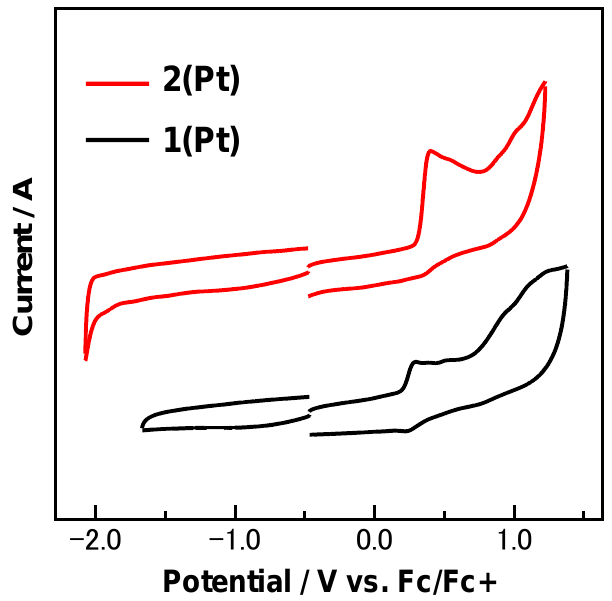
Figure 3. Room temperature cyclic voltammograms of 2(Pt) and 1(Pt) in Ar-saturated 0.1 M [n-Bu 4 N]PF 6 PhCN sochartlution at a scan rate of 0.10 V s − 1 with all platinum electrodes.